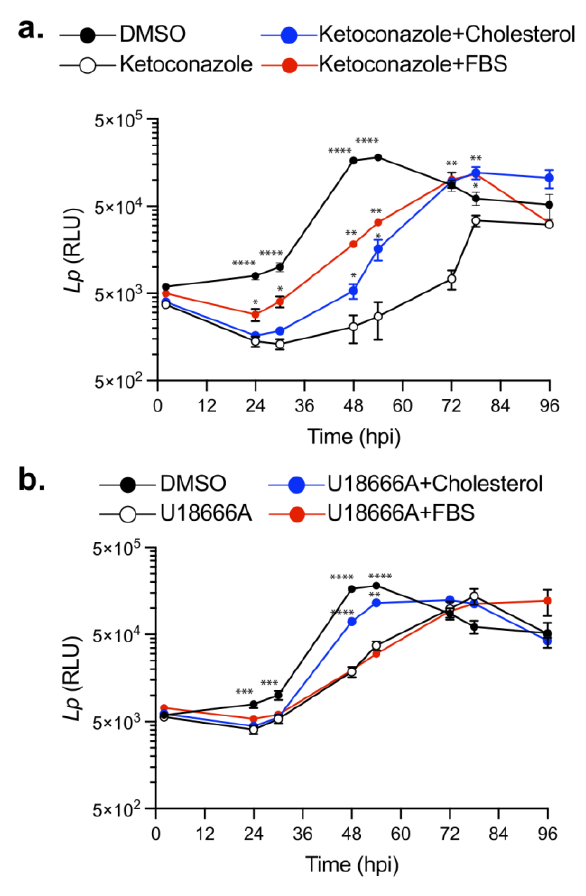
FIGURE 3: Impact of cellular cholesterol on Lp intracellular repli- cation. Intracellular bacterial replication measured by lumines- cence output over 96 hrs from BMDMs infected with Lp icmRp - LuxR at MOI of 7.5 in the absence or presence of 3.3 µM ketocona- zole (a) , 5µM U18666A (b) , 5µM cholesterol (a-b) , 1% (v/v) FBS (a- b) or DMSO (a-b) . Each data point represents an average of tech- nical triplicates ± SD. For statistical analysis, each data series was compared to the data series obtained from the ketoconazole only- treated cells (a) or U18666a only-treated cells (b) using two-way ANOVA analysis. **** p<0.0001; *** p<0.0002; ** p<0.0021; * p< 0.033 (a-b) Representative data from one of three biological repli- cates are